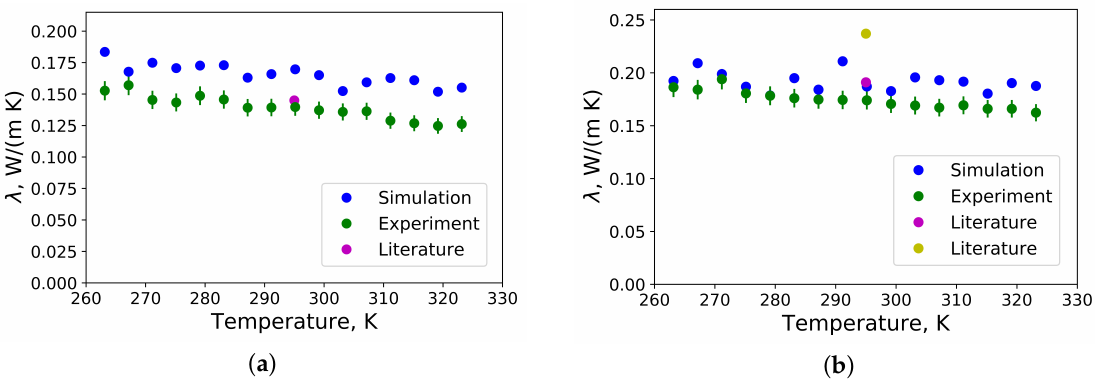
Figure 3. ( a ) Thermal conductivities of polyisoprene as function of temperature. For comparison, literature data from [18] are taken; ( b ) Thermal conductivity of polybutadiene as function of temperature. For comparison, literature data from [17] are taken: magenta and yellow circles indicate thermal conductivities of medium vinyl content polybutadiene with a molecular weight of 2600 g/mol and highly vinyl content polybutadiene with a molecular weight of 100,000 g/mol,